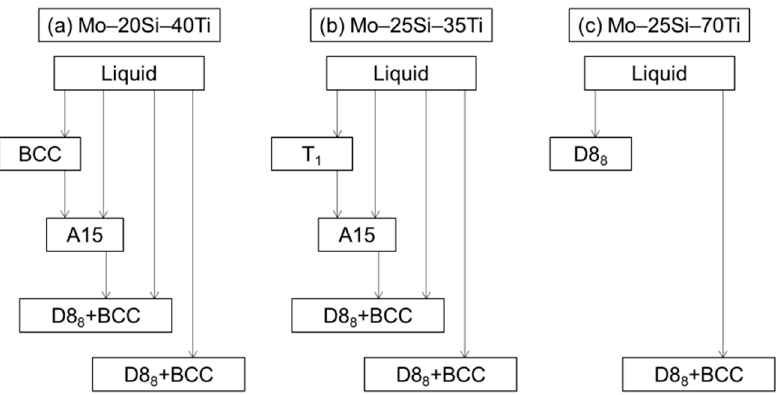
Figure 4. Brief flow chart of the solidification sequence for ( a ) Mo–20Si–40Ti, ( b ) Mo–25Si–35Ti and ( c ) Mo–25Si–70Ti alloys (at.%).